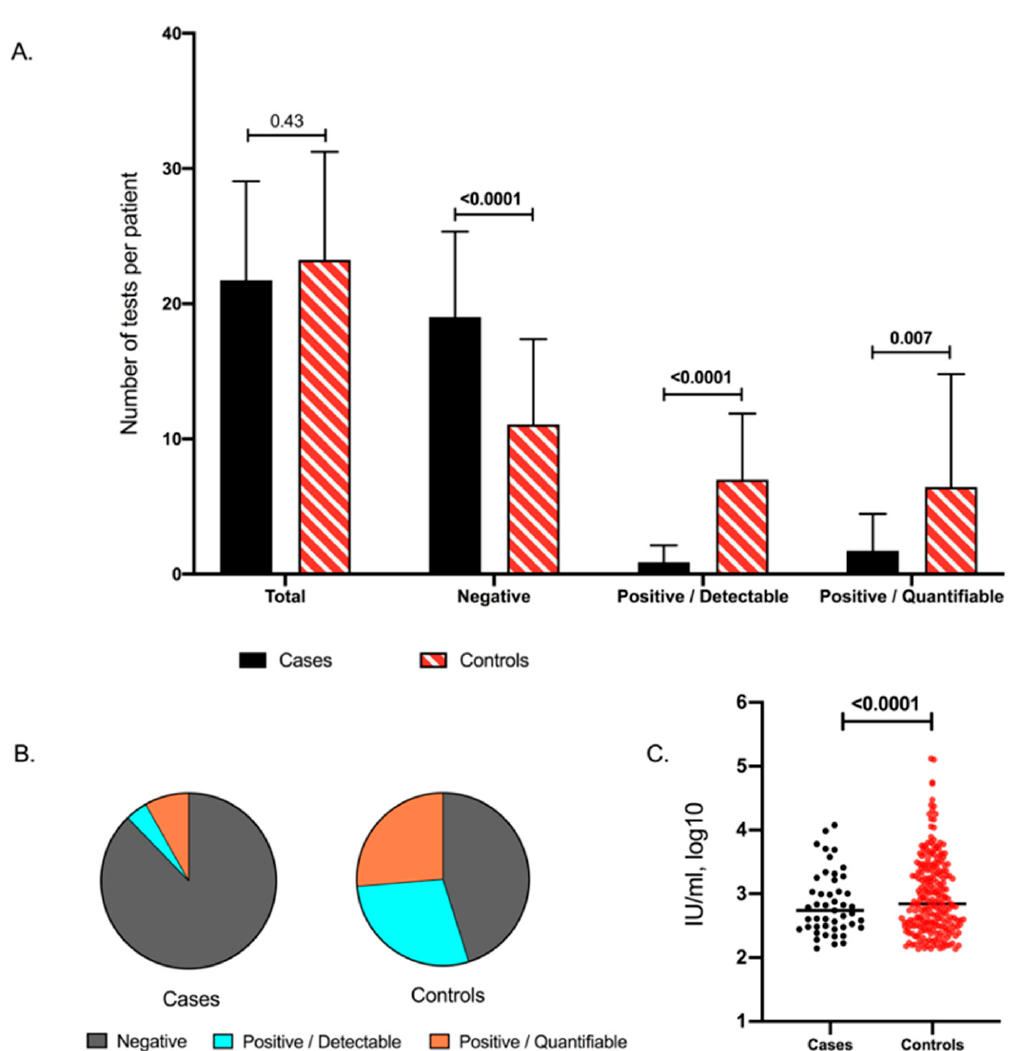
Figure 2. ( A ) Numbers of quantitative CMV PCR detection tests performed during the study period between cases and controls, presented as negative (<56 IU/mL), positive/detectable (56–136 IU/mL) and positive/quantifiable (>137 IU/mL). ( B ) Proportions of negative, positive/detectable and positive/quantifiable CMV PCR tests between cases and controls. ( C ) Absolute values of positive/quantifiable quantitative CMV PCR tests between cases and controls.